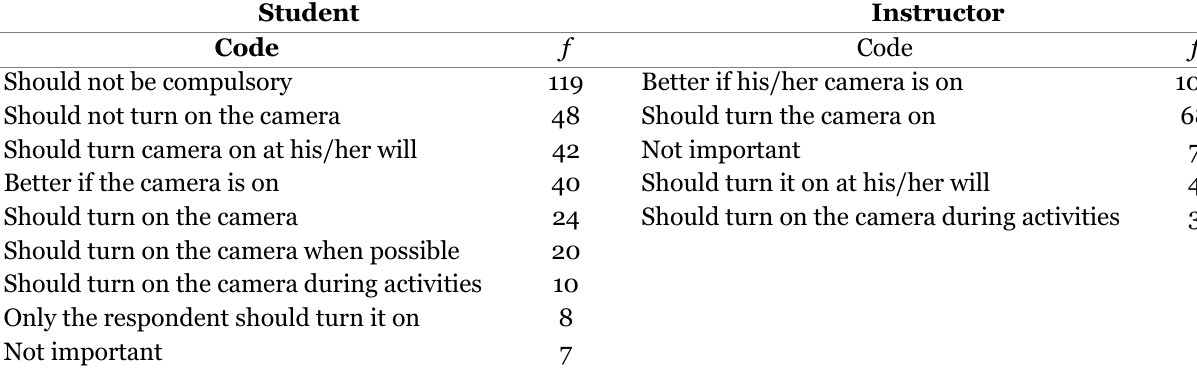
Table 3 PTs’ Responses: Should Students ’ and Teachers’ Web Cameras Be Turned On or